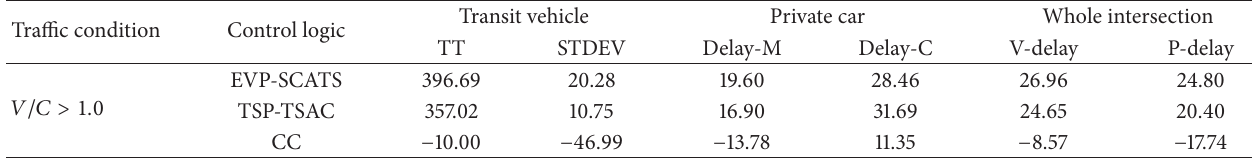
Table 3: The performance indices of the transit vehicle and the private vehicle at 𝑉/𝐶 > 1.0 .